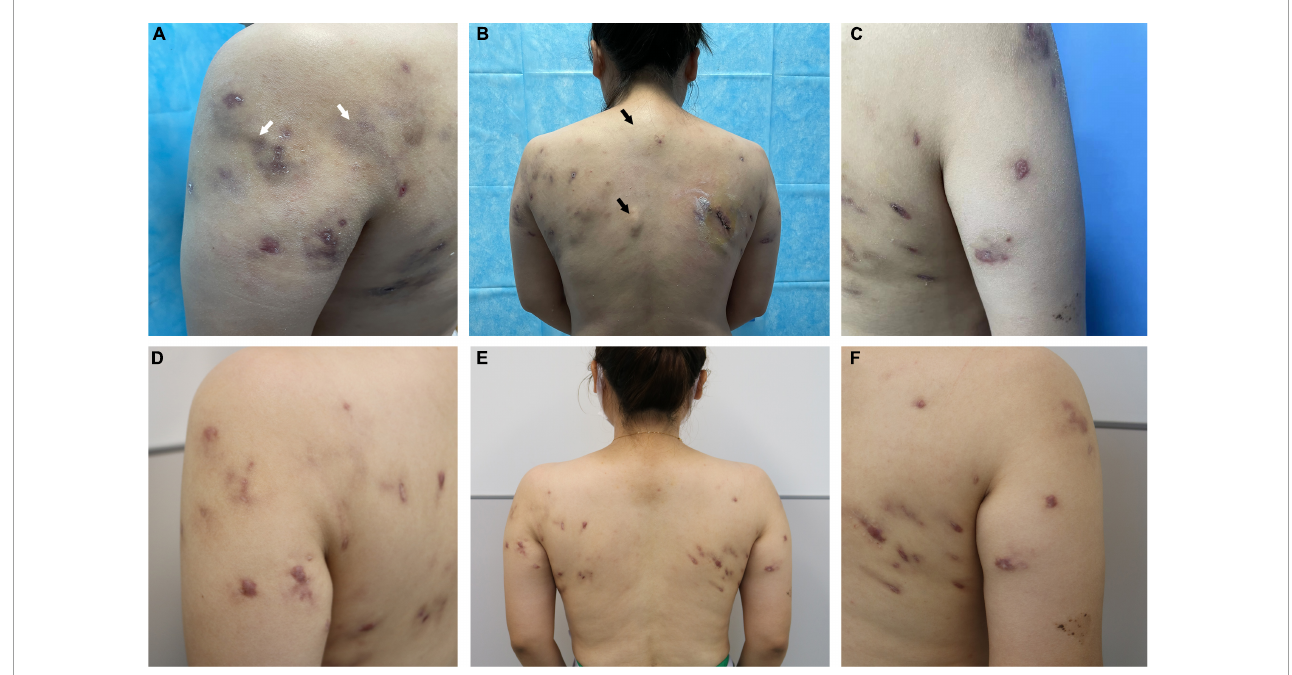
FIGURE1 Clinical images. Mycobacterium haemophilum infection after lipolysis injection at the initial visit (A) in the left shoulder, petechiae, and swelling (white arrows); (B) in the back, the area near the spine (not injected) also showed significant occupancy (black arrows); and (C) in the right shoulder. (D–F) Significant improvement in the patient’s eruption can be observed after treatment.